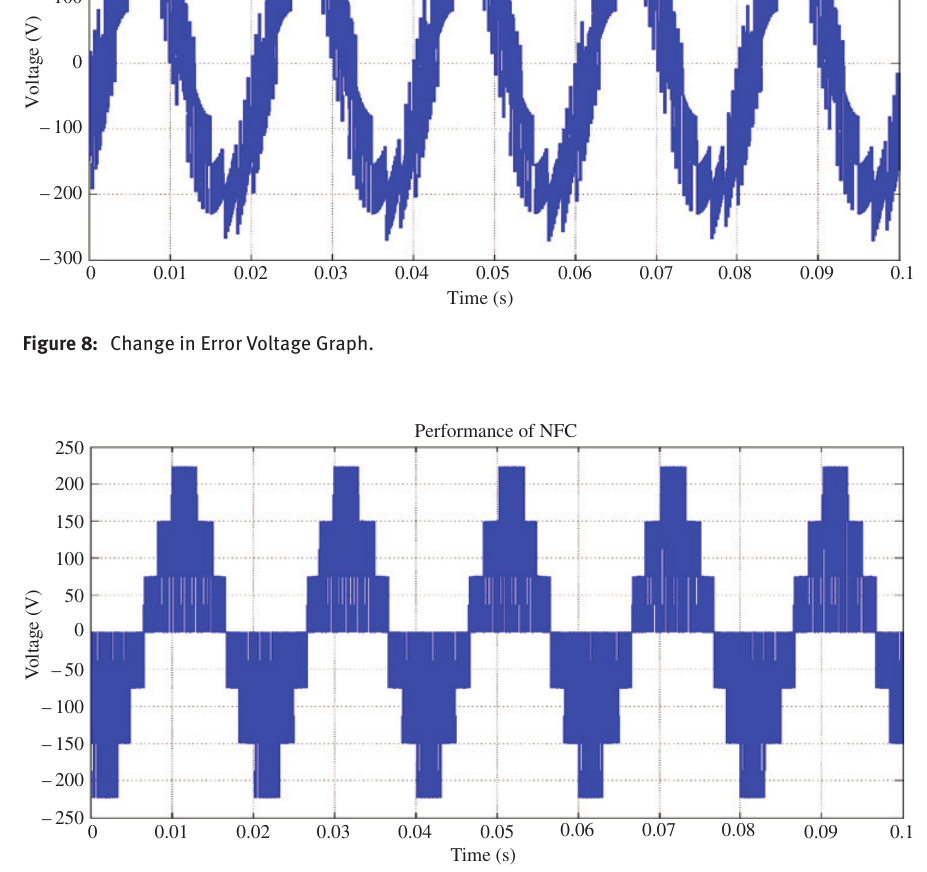
Figure 9: Seven-Level Inverter Output Voltage with